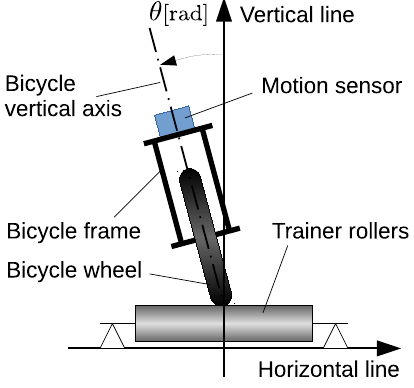
Figure 2. Schematic front view of the bicycle during the